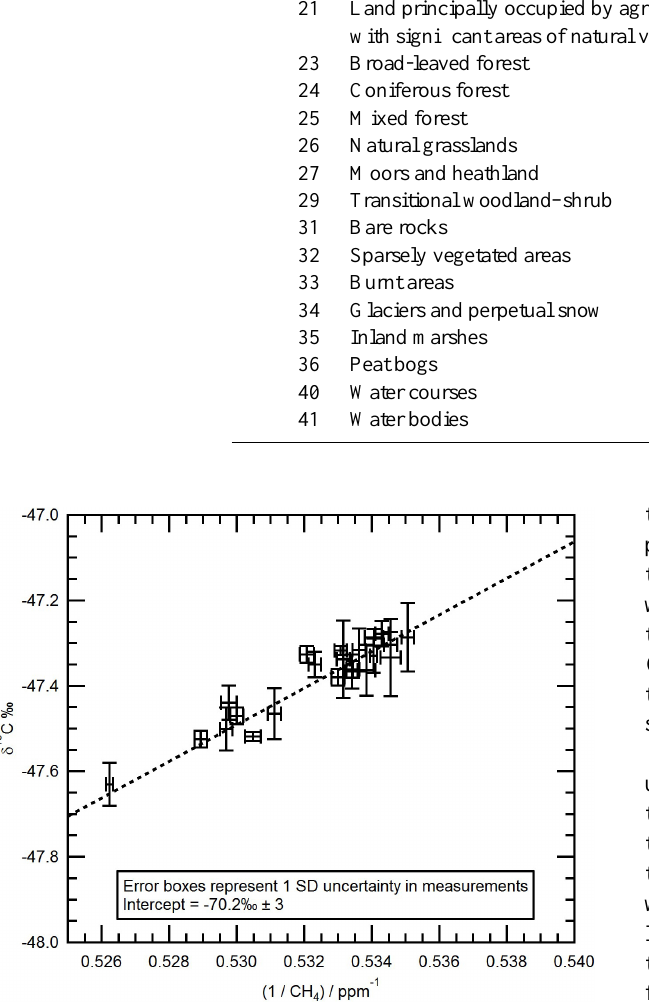
Figure 4. Keeling plot showing PBL measurements of δ 13 C– CH 4 during flight on the 22 July 2012 (B720). The intercept of − 70.2 ± 3.0‰ is representative of a wetland source of CH